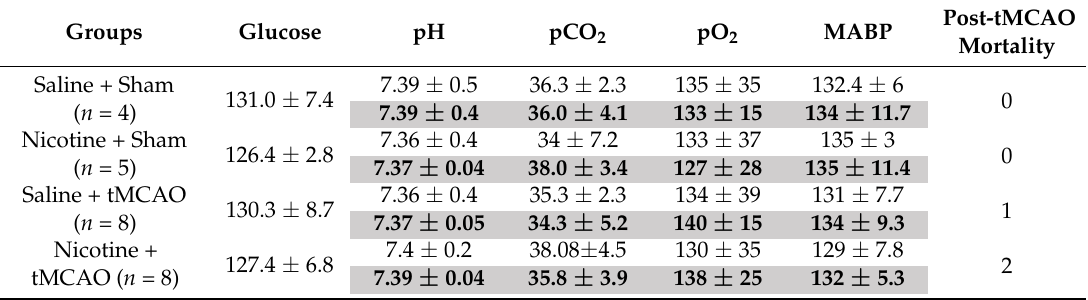
Table 1. Physiological variable. Physiological variables were recorded during the period when the animal was under anesthesia. Rows with bold background denote values after tMCAO. Mean arterial blood pressure